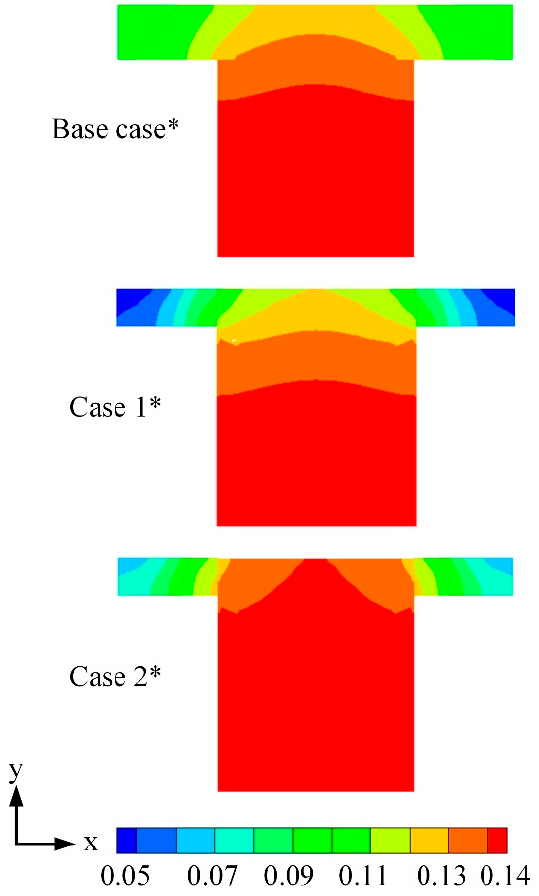
11 of 18 Figure 5. Equivalent stress distribution of the membrane in Case 1* and Case 2*. The deformations of each component from different models are then exported to draw the corresponding 3D PEMFC geometric model, which is imported into the CFD model to obtain the transport characteristics and performance of the PEMFC for the three cases. Figures 6 and 7 show the distribution of the oxygen mass fraction in the Base case*,